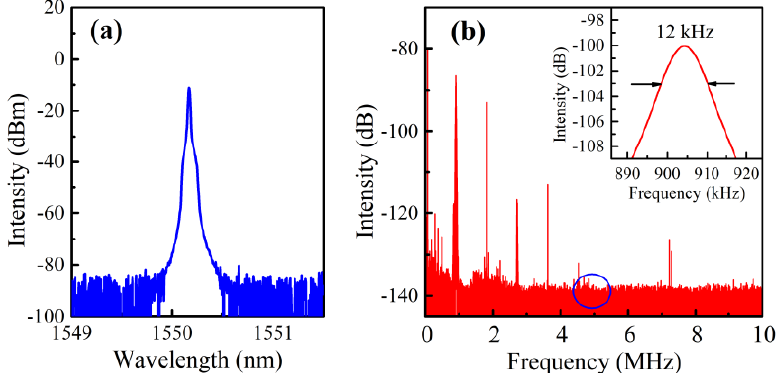
Figure 4. ( a ) The spectrum of the output laser. ( b ) The measurement result of the linewidth by the DSHI device. DSHI